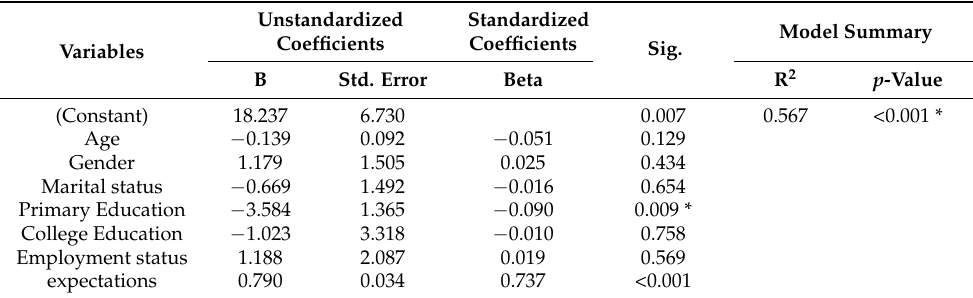
Table 3. Multiple regression analysis for variables associated with perception.